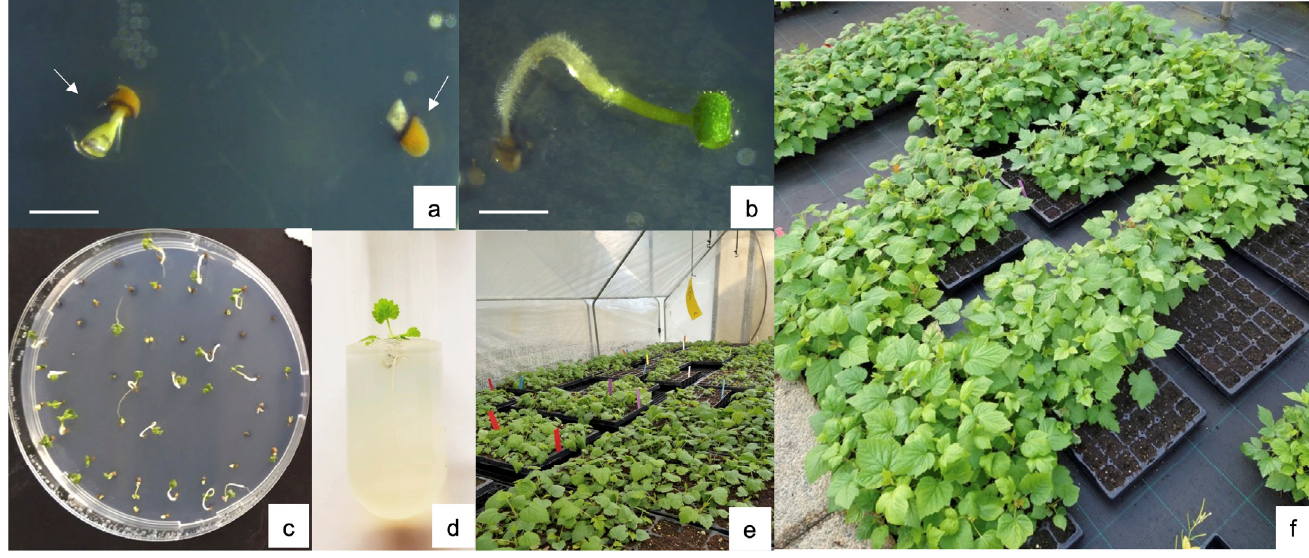
Figure 3. In vitro germination, rooting, and acclimatization of Polka seeds cut in half and placed directly under 24 °C (bT2) treatment. ( a ) The two halves of the seed at 4 days after treatment are indicated by white arrows; ( b ) a well-developed seedling from germinated seed after 7 days of in vitro culture (scale bar = 2 mm); ( c ) in vitro germination of seedlings after 10 days of in vitro culture; ( d ) in vitro raspberry shoot elongation and rooting; ( e ) gradual acclimatization of raspberry seedlings under plastic tunnel; ( f ) well-established in vivo plants in the greenhouse ready to be transferred to field conditions.